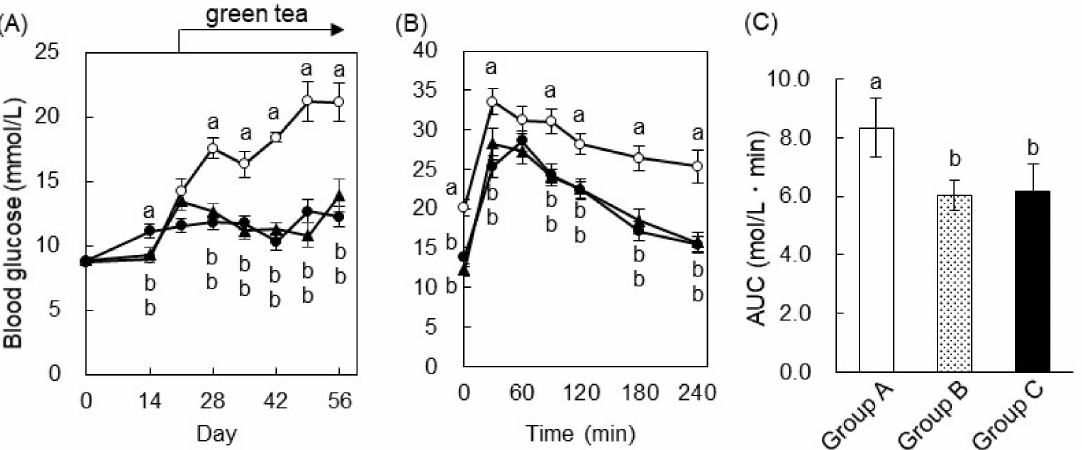
Figure 5. Green tea ameliorated hyperglycemia and glucose intolerance in KK-A y mice, a type 2 diabetes mellitus (T2DM) model. Mice were treated as shown in Figure 1B. ( A ) Blood glucose concentrations were measured weekly during the feeding study. ( B ) An OGTT was performed on Day 56. The mice were orally administered glucose (2 g / kg body weight) 6 h after fasting, and the blood glucose level was measured 0, 30, 60, 120, 180, and 240 min later. Here, : Group A; (cid:8) : Group B; and (cid:78) : Group (cid:35)